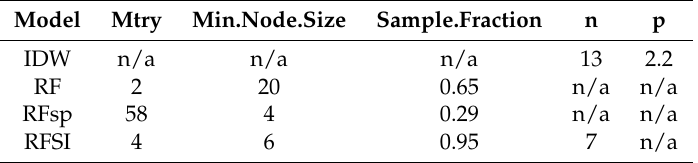
Table 3. Optimized hyperparameters of IDW, RF, RFsp and RFSI for the precipitation case